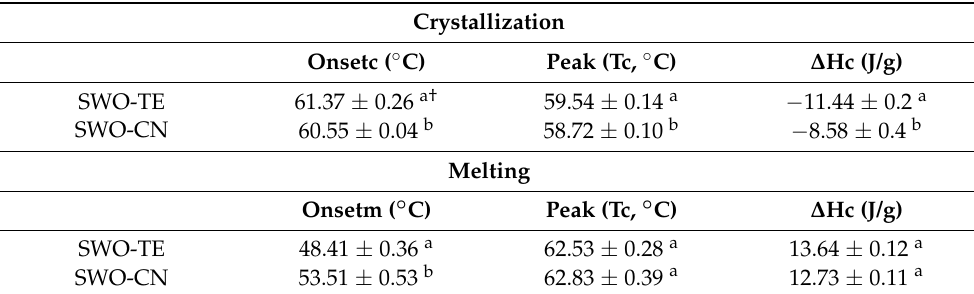
Table 2. The thermal properties of the prepared thyme and cumin-flavored virgin olive oil-sunflower wax